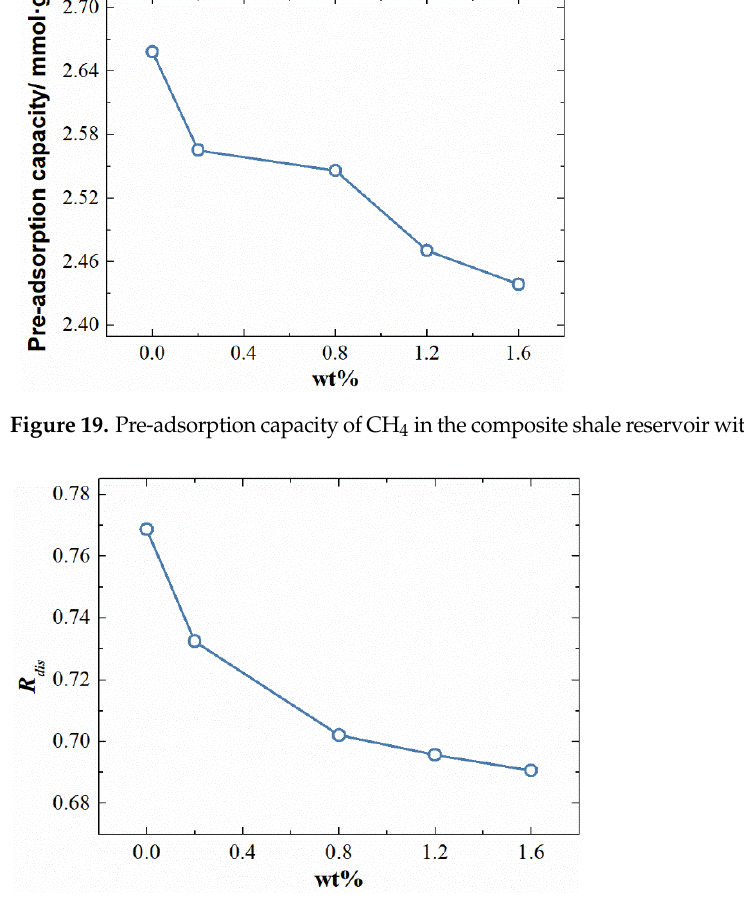
Figure 20. The displacement efficiency of CH 4 in the composite shale reservoir with different wa- ter contents.